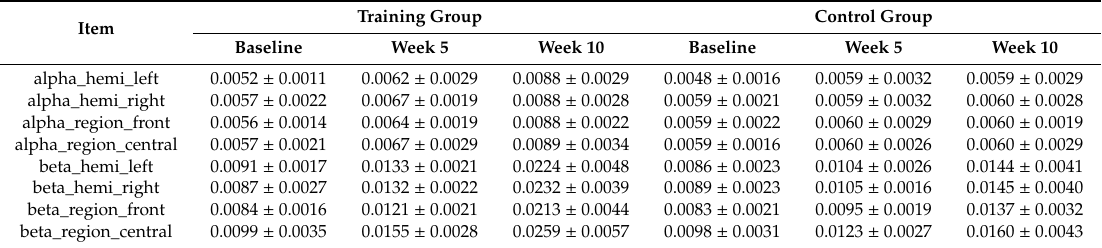
Table 12. Pre- and post-intervention changes in the alpha- and beta-wave power of all brain areas of the subjects ( N = 41; X ± SD).